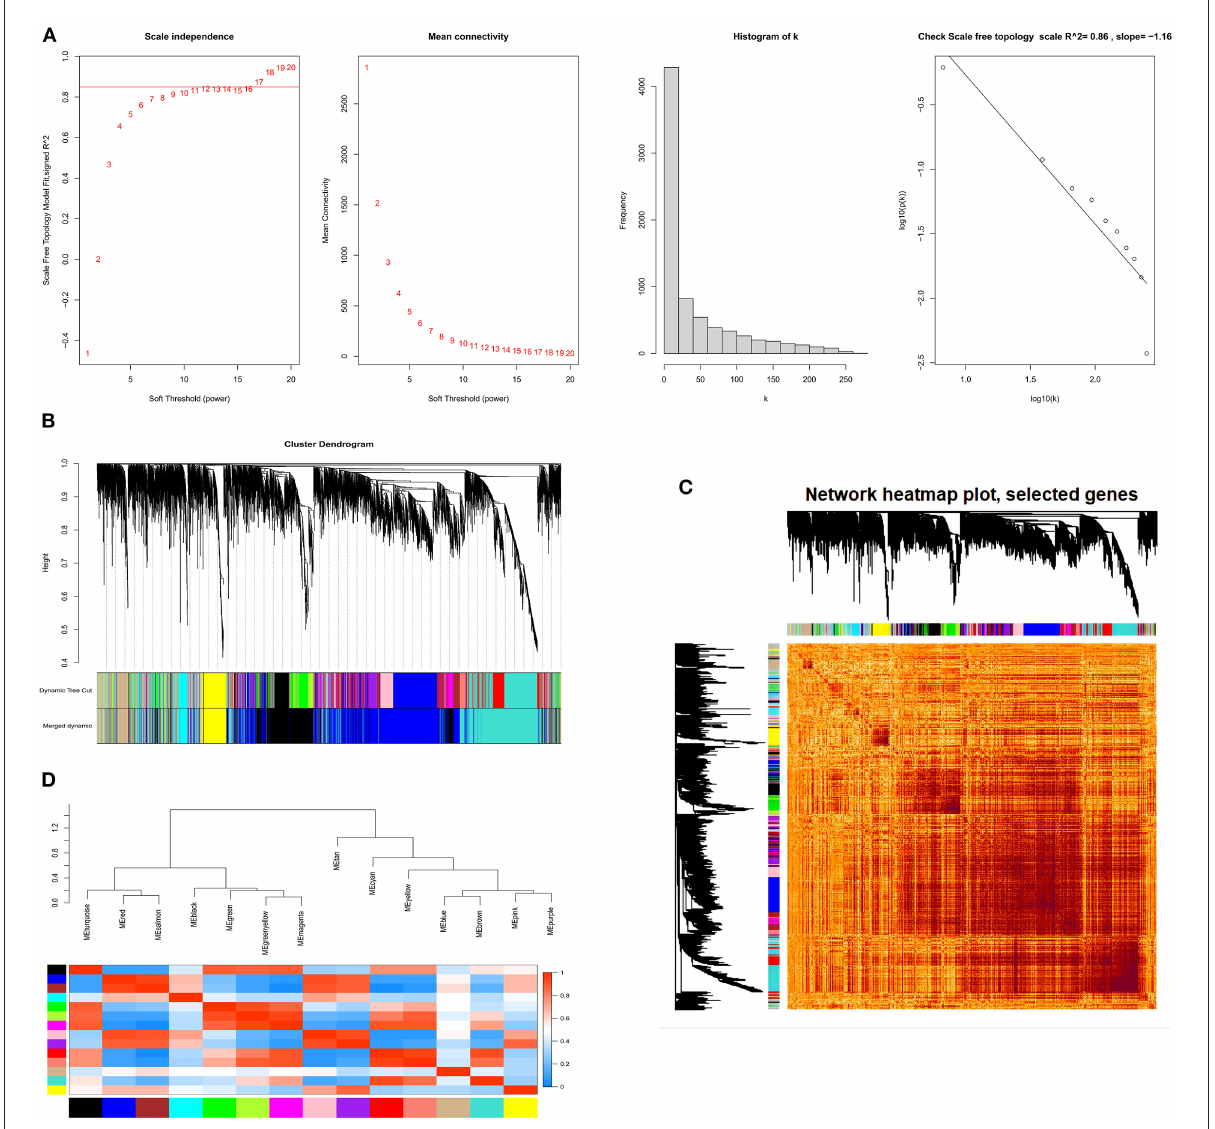
FIGURE6 The process of screening follicular development mRNAs using WGCNA. (A) Network topology analysis for various soft-threshold powers. Scale-free topologies were examined; the adjacency matrix was defined using a soft threshold of β = 17. (B) Clustered dendrograms of genes, based on differences in topological overlap, and the specified module colors. (C) Heat map of the intergenic topological overlap matrix (TOM) based on co-expression modules. A redder background indicates a higher module correlation. (D) Visualization of gene networks using heat